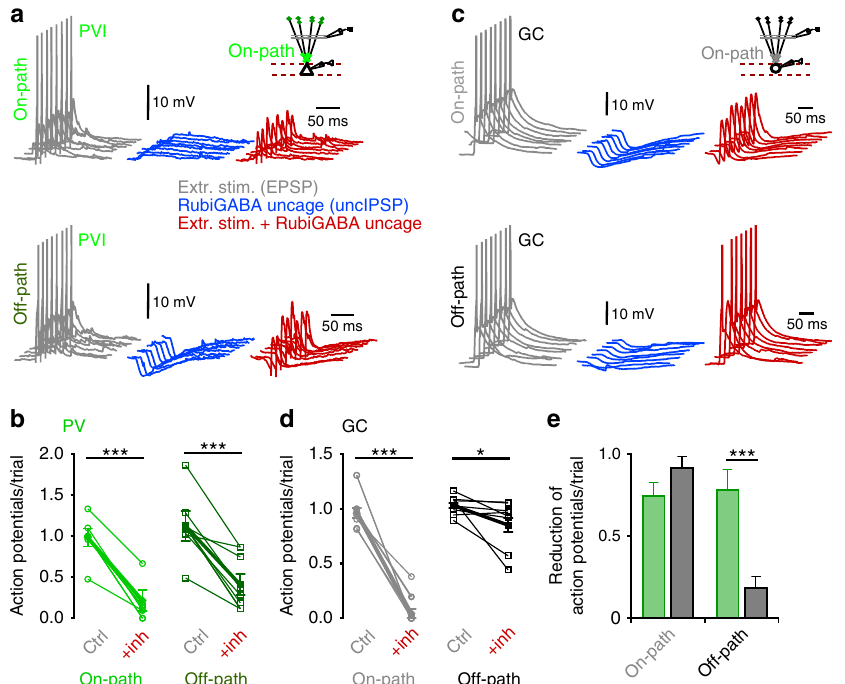
Fig. 4 Off-path inhibition ef fi ciently controls recruitment of PVIs but not GCs. a , c Experiments were performed as in Fig. 3, with supra-threshold perforant path fi ber stimulation to evoke action potentials. UncIPSPs were induced by sequential RubiGABA uncaging at seven different distal or proximal dendritic locations. Gray traces show subsequently evoked action potentials under control conditions, blue traces represent individual uncIPSPs and red traces depict PSPs resulting from the interaction of uncIPSPs and supra-threshold EPSPs for on-path (upper traces) and off-path inhibition (lower traces). b , d Graphs summarize the effect of on- and off-path inhibition on action potential number per trial in PVIs ( b ) and GCs ( d ). Open circles and squares connected by lines represent data from individual cells; fi lled circles with lines and bars depict mean ± s.e.m. e Summary bar graph showing the average reduction in action potential number per trial during on- or off-path inhibition in PVIs (green) and GCs (gray). Note that on- and off-path inhibition are similarly effective in controlling action potential generation in PVIs but not in GCs. * p ≤ 0.05; *** p ≤